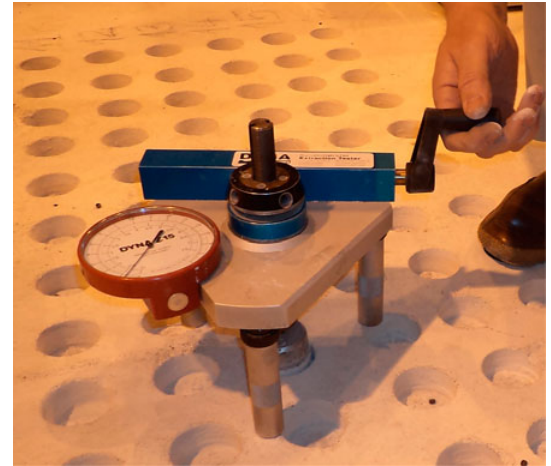
Fig. 11. Testing by means of semi-nondestructive pull-off